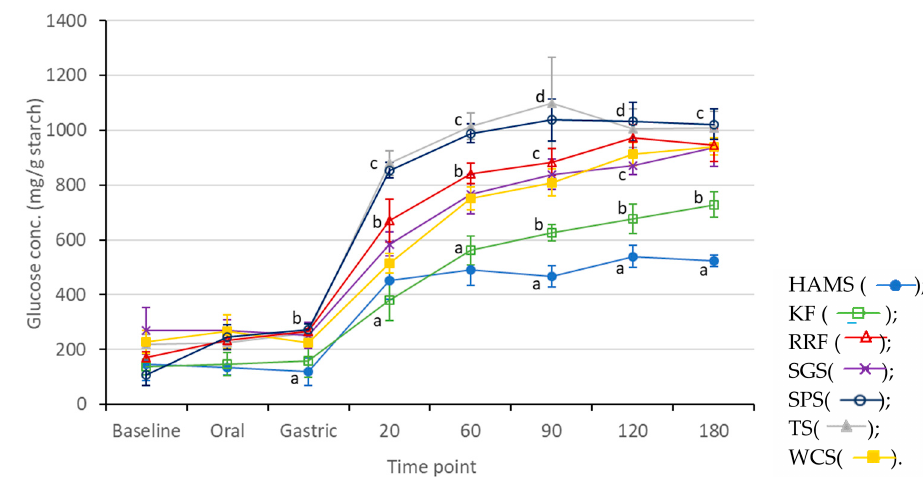
Figure 3. The in vitro digestibility of the starch/flour gels. The amount of sugar released across the digestion phases was expressed as means ± standard deviations plotted in error bars ( n = 4). Values with different letters (a–d) in the same time point are significantly different ( p < 0.05) according to